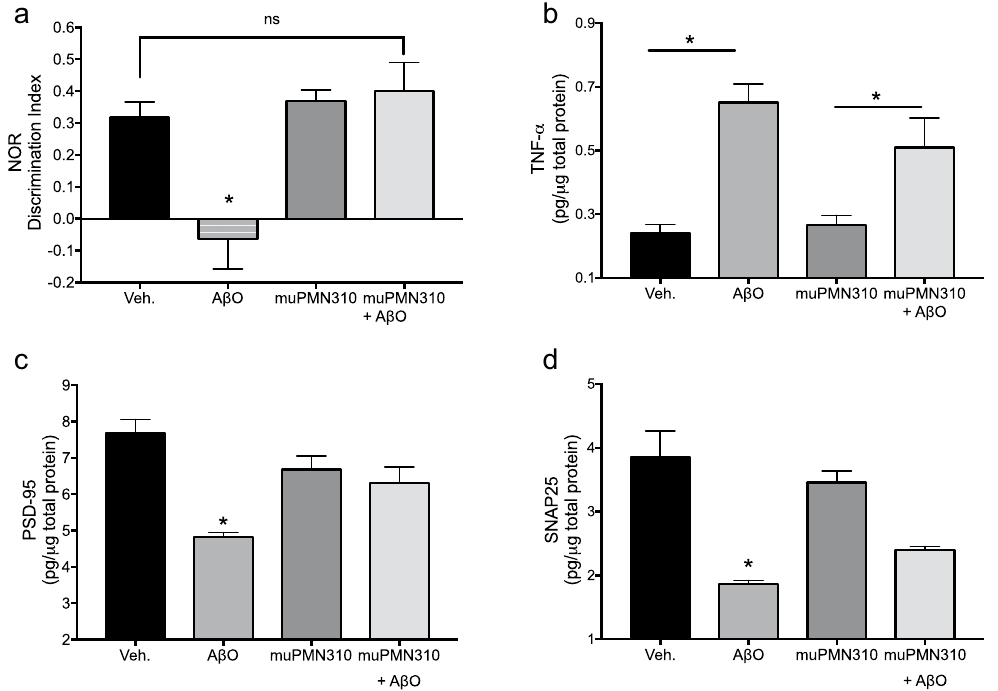
Figure 5. muPMN310 inhibits A β O toxicity in vivo . Wild-type mice (n = 12 per group) were injected i.c.v. with either vehicle (Veh.), A β 42O + vehicle (A β O), muPMN310 + vehicle (muPMN310) or muPMN310 + A β O at a molar ratio of 2:1. ( a ) NOR discrimination indices (n = 7–10 evaluable mice per group). Mean ± SEM shown. Data were not normally distributed. Differences were compared using Kruskal-Wallis ANOVA with Dunn’s multiple comparison test. A β O is significantly less than all other samples ( * p ≤ 0.05 vs Vehicle, muPMN310, muPMN310 + A β O). No other comparisons were significant, including Veh.:PMN310 + A β O. Hippocampal levels of TNF-alpha ( b ), PSD-95 ( c ), SNAP25 (d) (n = 11–12 mice per group). Mean ± SEM shown. Differences were compared using one-way ANOVA with Tukey’s multiple comparison test for normally distributed data in ( b : * p ≤ 0.05) and ( c ). ( d ) Difference determined with Kruskal-Wallis ANOVA with Dunn’s multiple comparison test for non-normally distributed data. In ( c , d ) * p ≤ 0.05 for A β O vs Veh., muPMN310, muPMN310 + A β